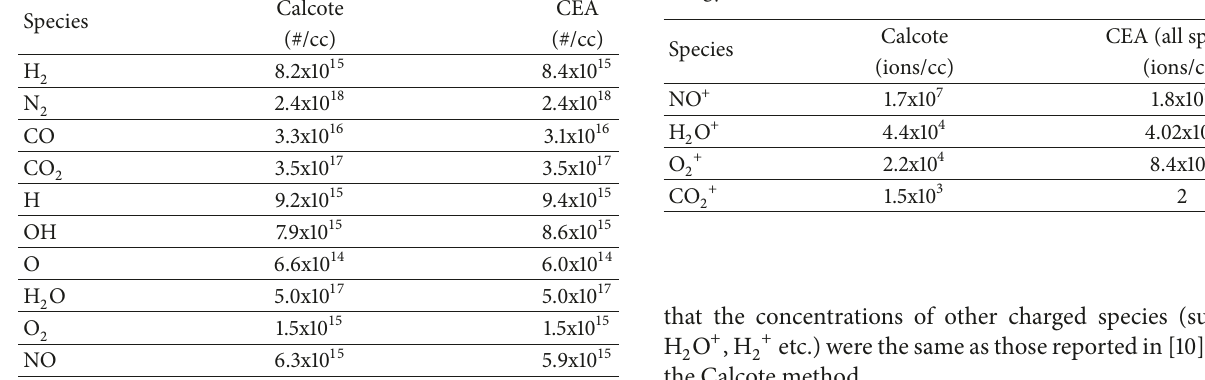
Table 2: Comparison of the dominant equilibrium ion concentra- tions using the Calcote method and minimization of the Gibbs free energy